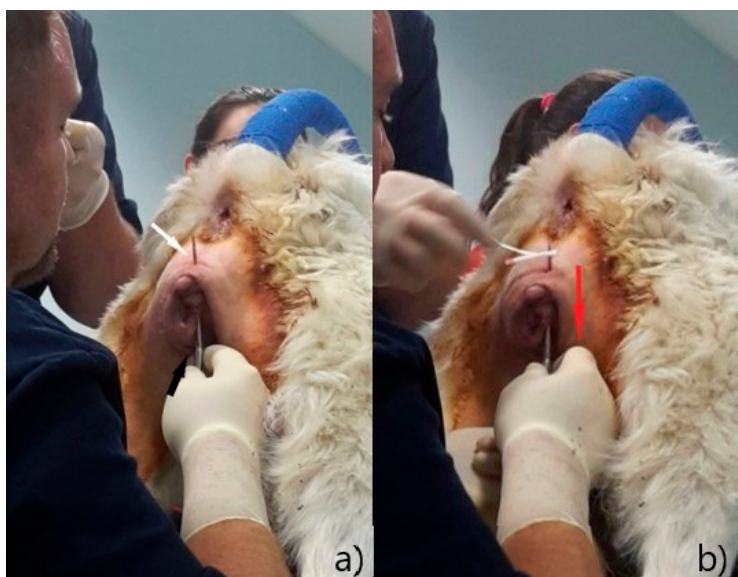
Figure 3 . ( a ) Gerlach needle; ( b ) sterile vaginal tape . Figure 3. ( a ) Gerlach needle; ( b ) sterile vaginal tape.